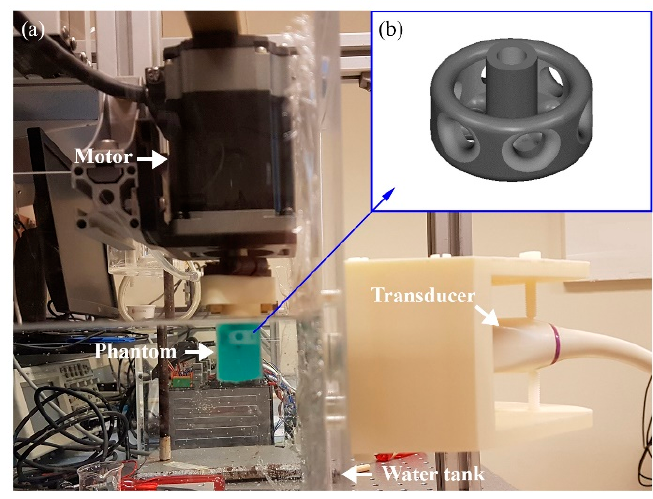
Figure 2. ( a ) Experimental setup rotating disk experiments. The cylindrical phantom is attached to the motor unit, using the fixating structure ( b ) and placed in a water tank. The transducer is positioned perpendicular to the phantom, at 3.4 cm from the center of the phantom.